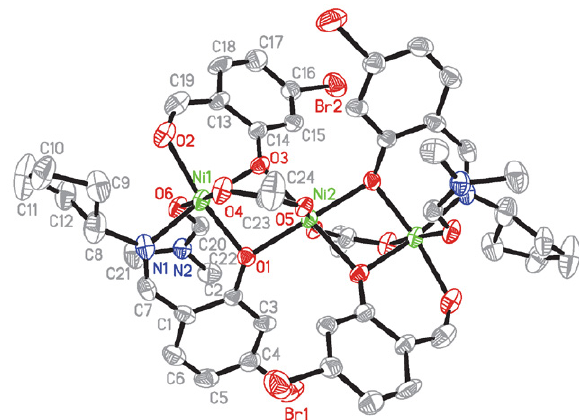
Table 2. Unlabeled atoms are related to the symmetry operation 1 – x , 1 – y , 1 – z